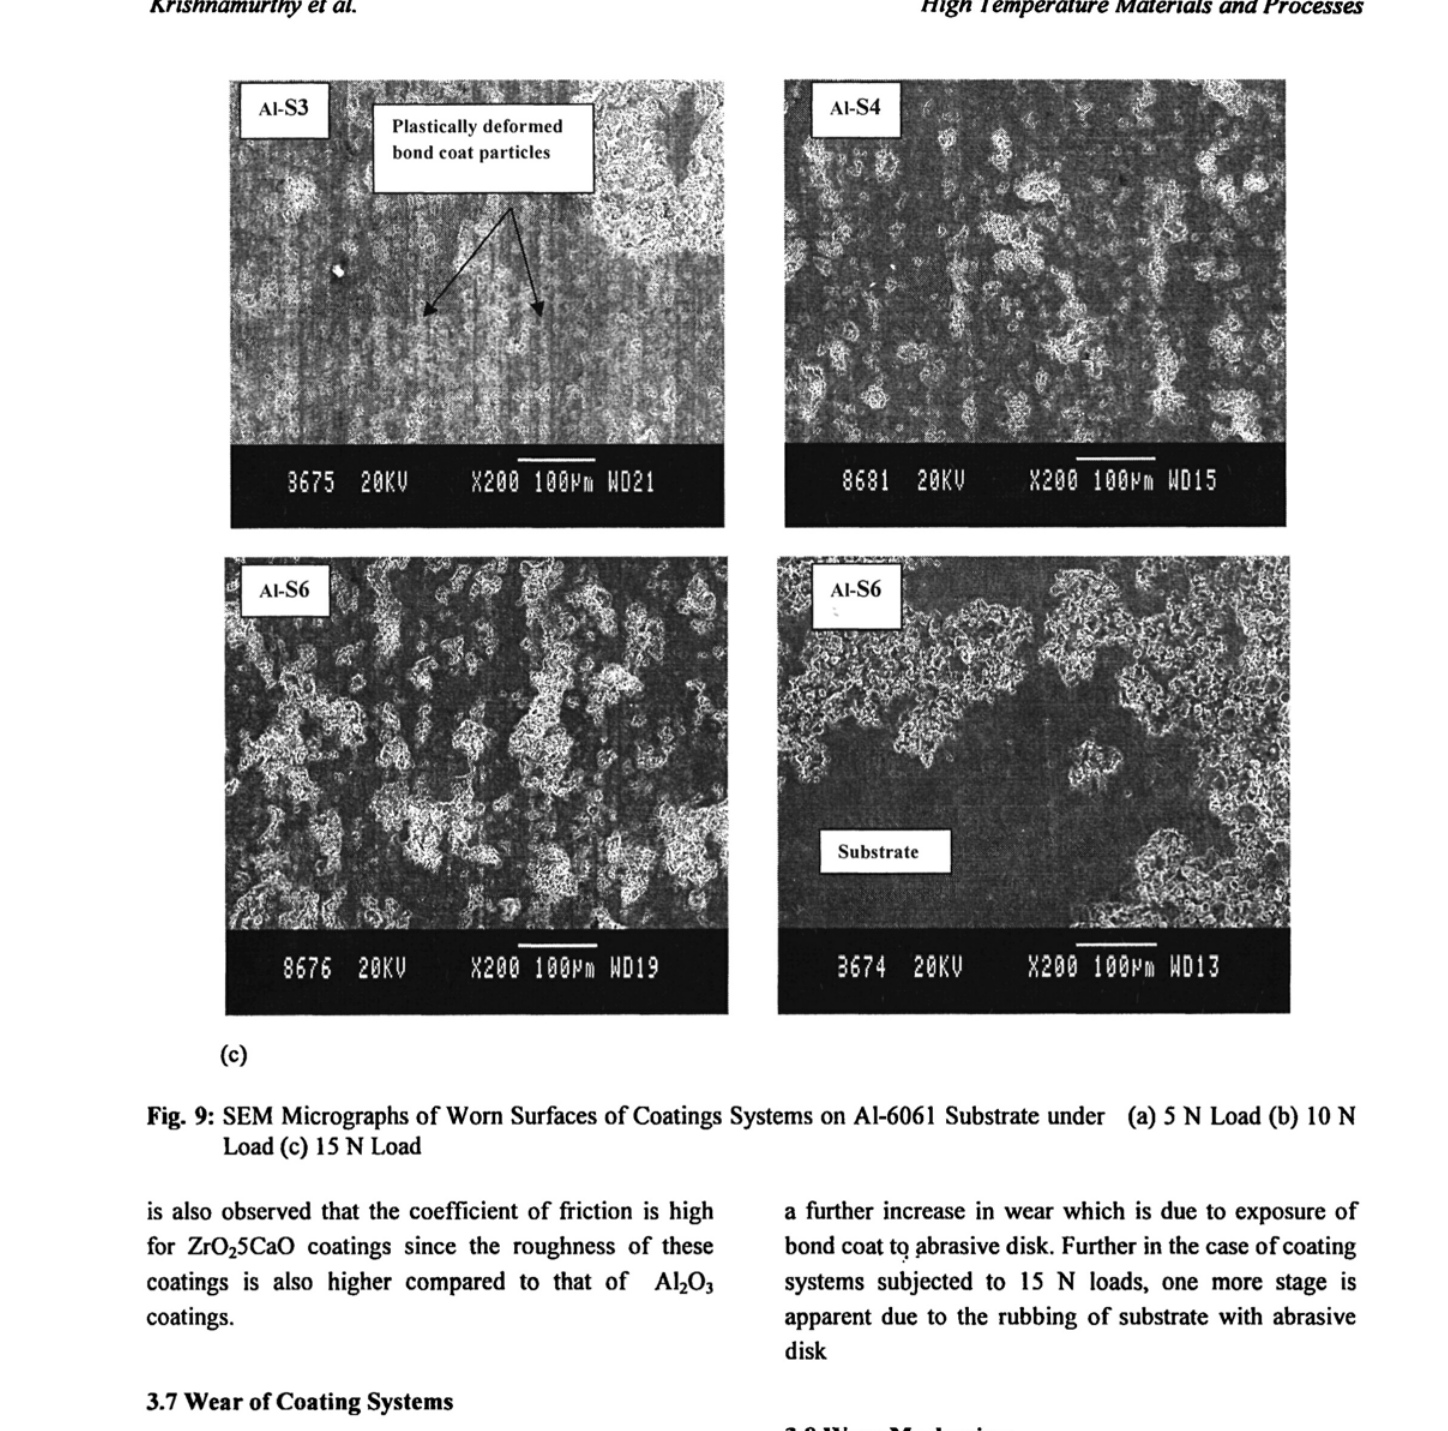
Fig. 9: SEM Micrographs of Worn Surfaces of Coatings Systems on Al-6061 Substrate under (a) 5 N Load (b) 10 N Load (c) 15 N